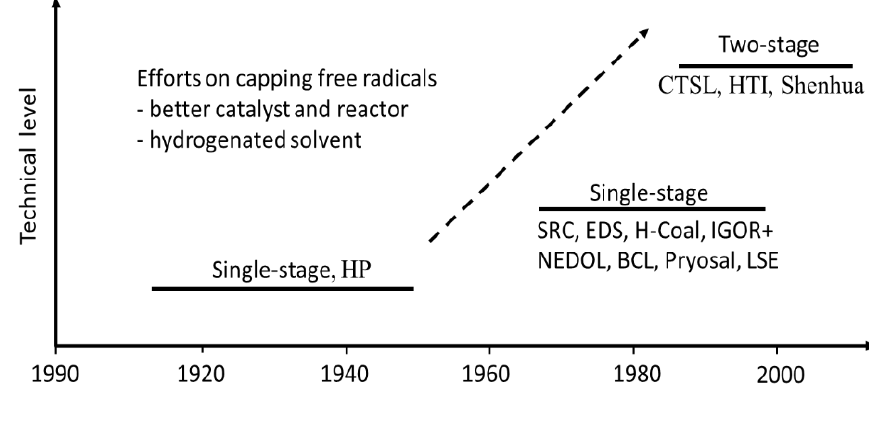
Figure 10. Developments of DCL technology [1].